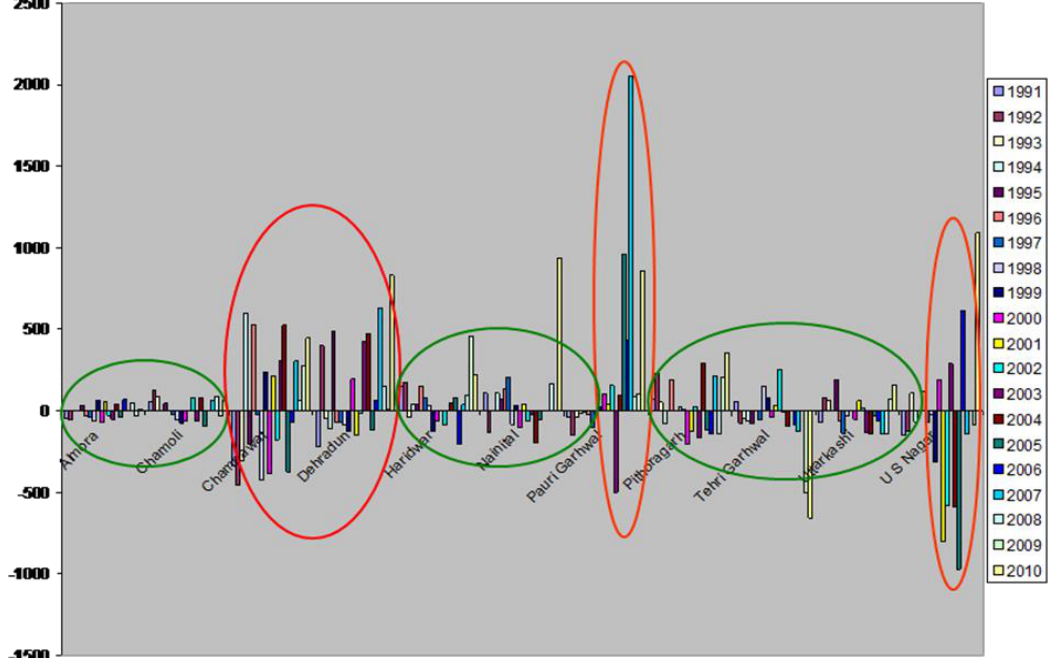
Fig. 6. Error estimate curve for the developed ANN